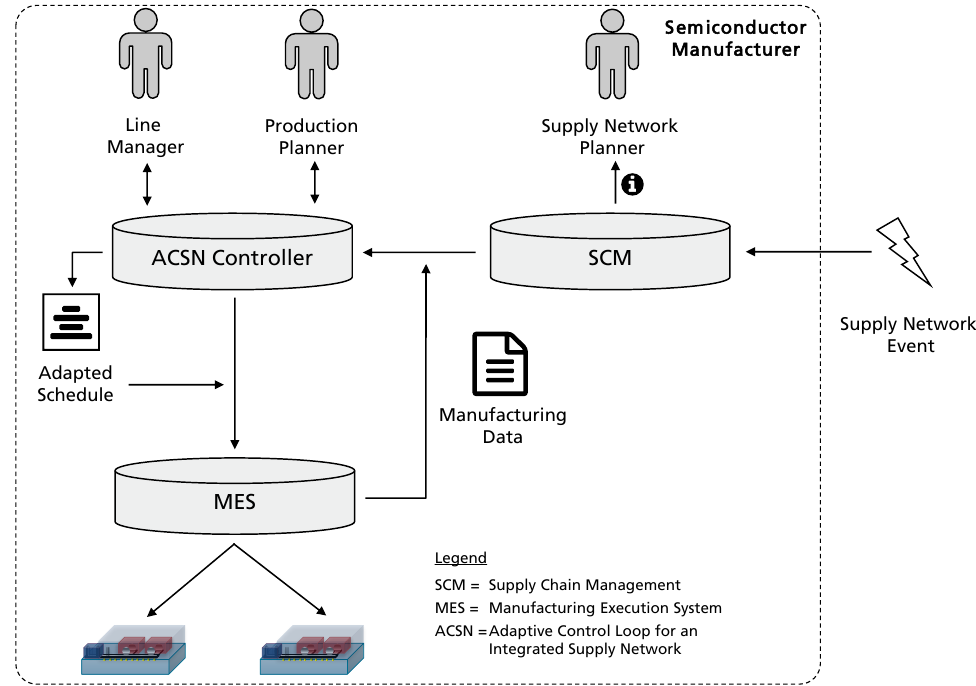
Figure 9. Optimized process for responding to supply network events by the adaptive control loop for an integrated supply